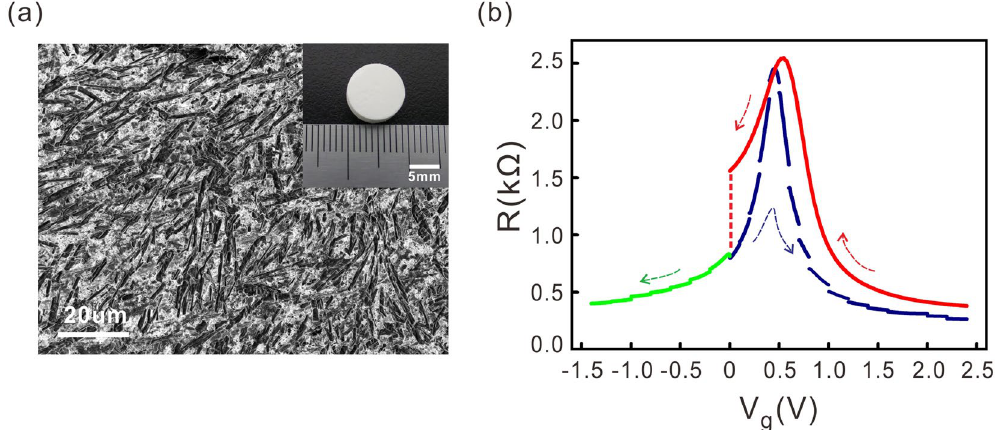
Figure 1. ( a ) Scanning electron microscope image of the surface of a hand-polished Nasicon type solid electrolyte substrate. Inset: photo of a hand-polished Na + -SE substrate. ( b ) Resistance variation of a single-layer graphene sheet with back gate voltage. The arrows in the figure indicate the direction of the voltage sweeping. The dashed line at zero gate voltage describes the evolution of the sample resistance during the relaxation of the accumulated sodium ions at the solid electrolyte/graphene